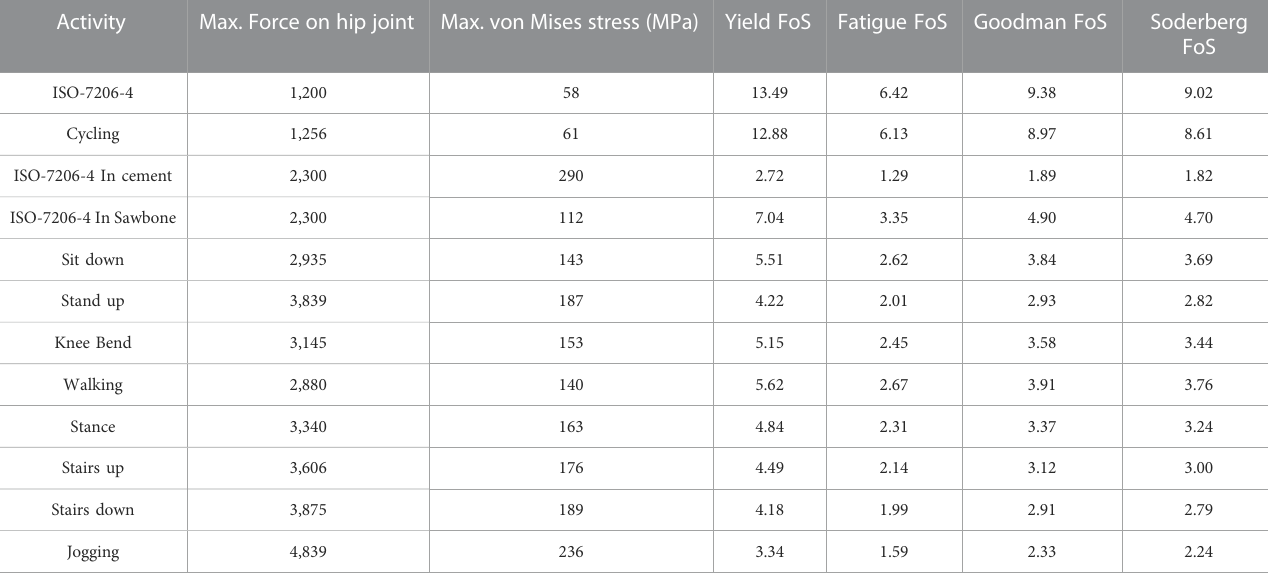
TABLE 5 Evaluation of maximum von Mises Stress, yield FoS, fatigue FoS, Goodman FoS and Soderberg FoS across varying physical activities and load levels for implanted porous stem. Activity “ ISO-7206-4 In cement ” was performed on the porous stem inside the bone cement with maximum von Mises stress at the distal restrictionpoint.AllotheractivitieswereperformedontheporoussteminsidetheSawbonewithmaximumvonMisesstressatthemedialneckofthestem(Bergmann et al.,